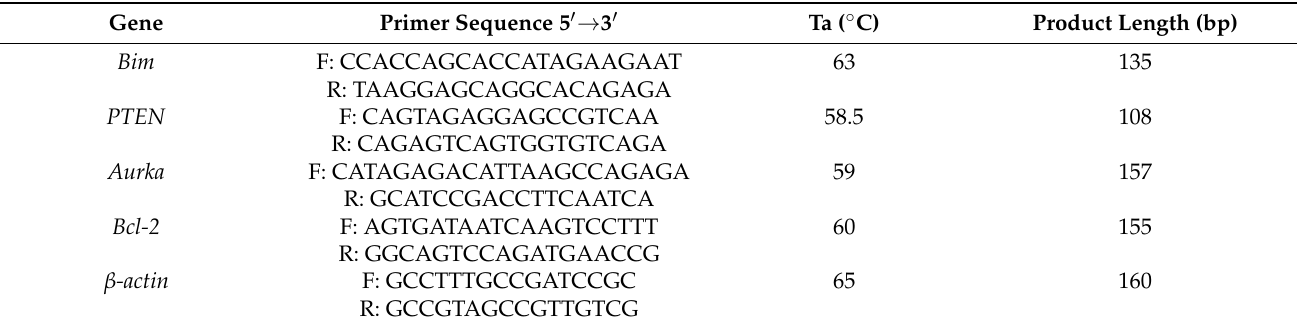
Table 6. Sequences of the primers used for RT-PCR amplification, product sizes, and